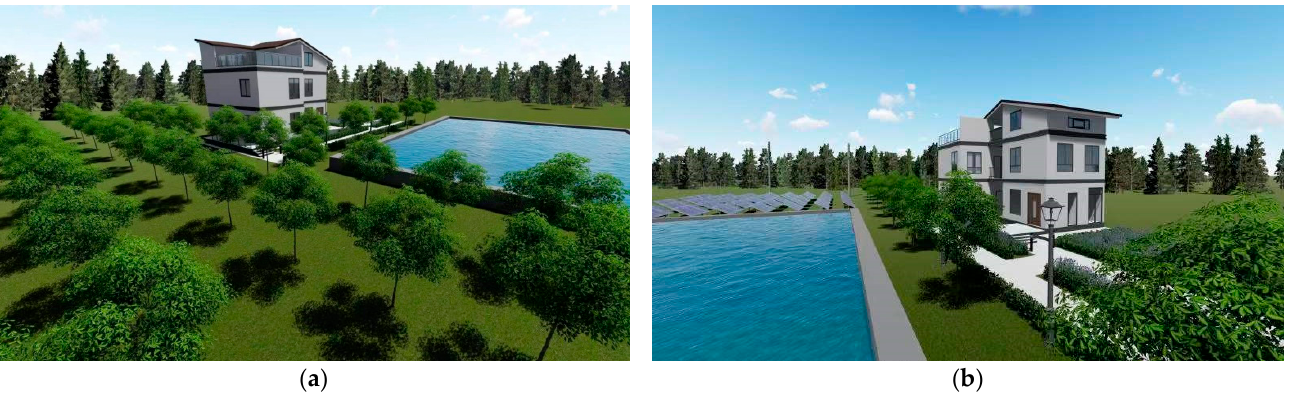
Table 10. Output values of each dimension of the residential houses (cases 1 and 2) from the DA- Fuzzy model. Dimension